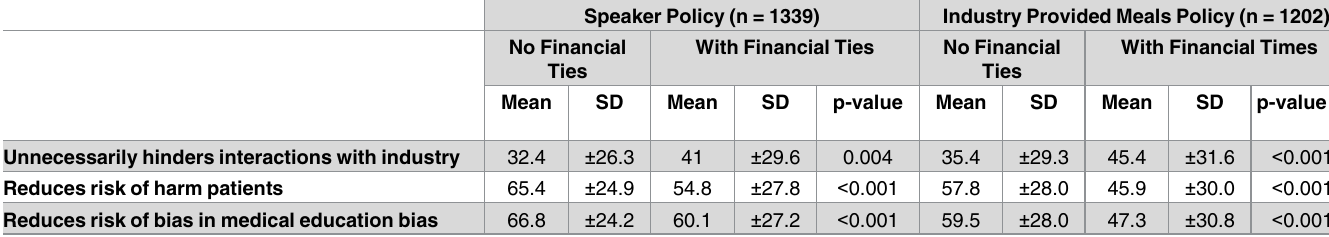
Table 6. Respondent perception of selectedCOI policies (%) by those with and without financial ties to